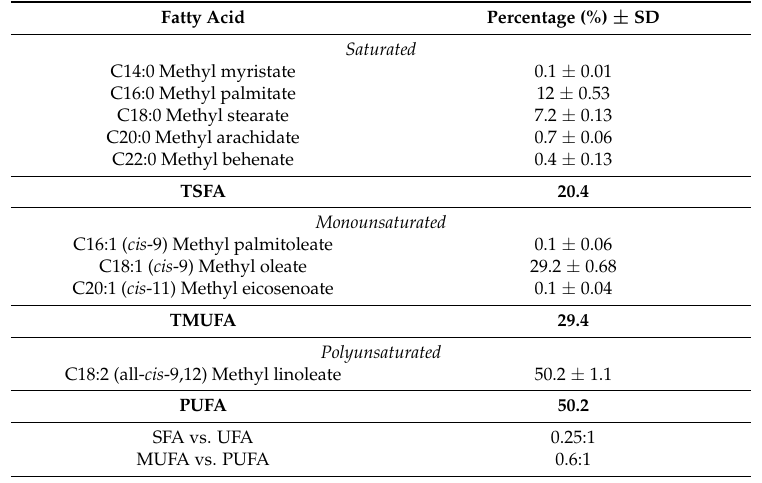
Table 2. Fatty acid profile of Terminalia ferdinandiana kernels expressed as percentage ( ± SD) of the total fatty acid profile as determined by FAME GC-MS